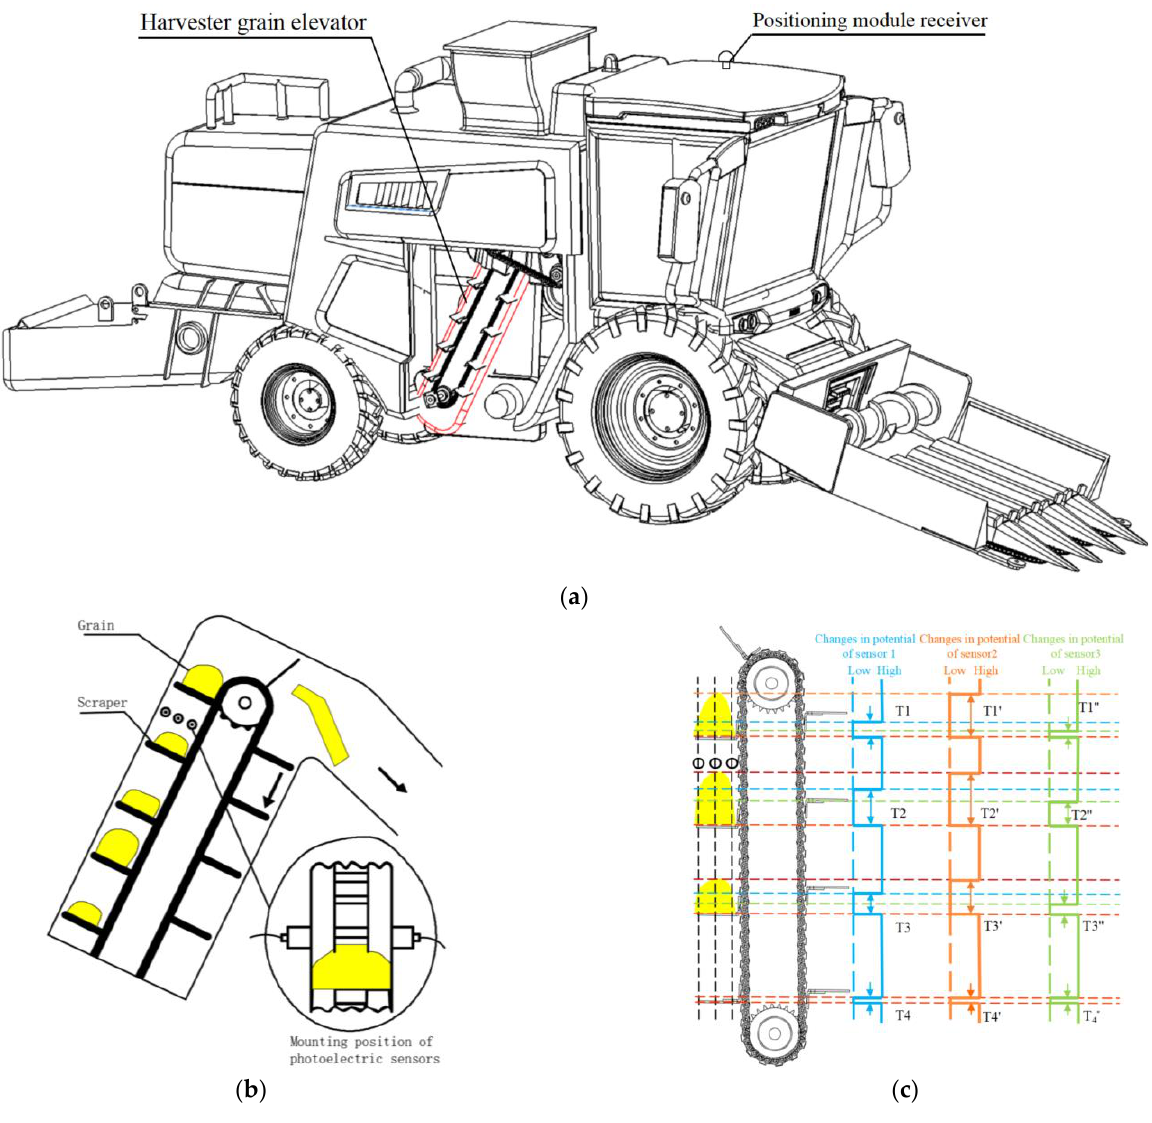
Figure 1. Grain yield monitoring principle: ( a ) overall structure diagram of yield monitoring system; ( b ) photoelectric sensors mounting position; ( c ) changes in sensor